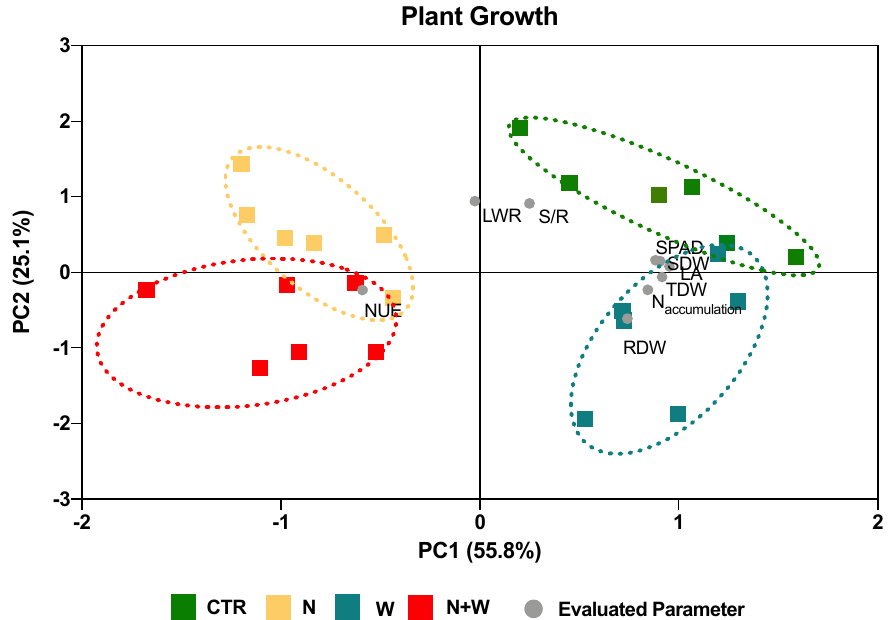
Figure 8. Principal component analysis (PCA) of the plant growth parameters evaluated in tomato cv. Micro-Tom grown for 16 days under control (CTR; 10.5 mM N + 100% W), nitrogen deficit (N; 5.3 mM N + 100% W), water deficit (W; 10.5 mM N + 50% W) or combined nitrogen and water deficit (N+W; 5.3 mM N + 50% W). The two principal components (PC1, PC2) explained 80% of the total variance found among treatments. Details on the abbreviations are given in Material and Methods.